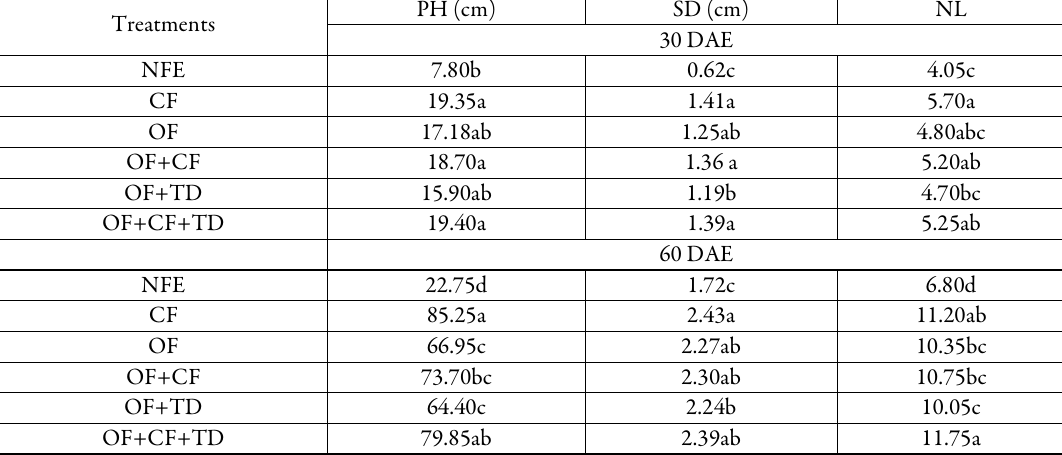
Table 3. Plant height (PH), stalk diameter (SD) and the number of leaves (NL) of the corn cv. ‘Potiguar’ under different organic-mineral fertilization management evaluated at 30 and 60 DAE